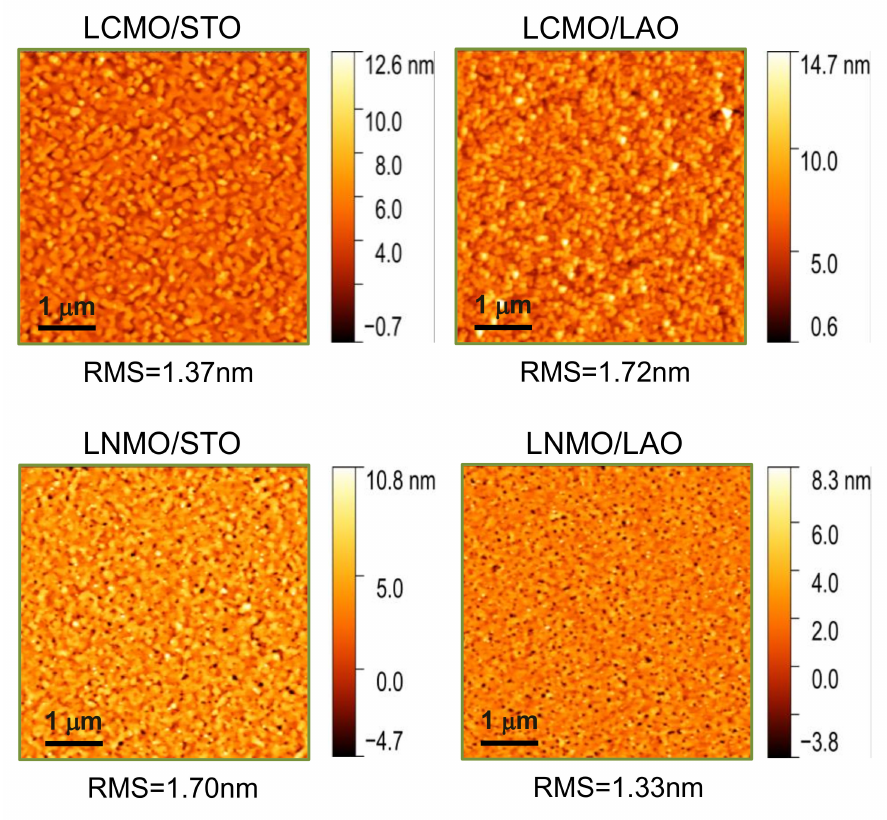
Figure 1. Atomic force microscopy surface topography images (5 × 5 µ m 2 ) of representative La 2 CoMnO 6 and La 2 NiMnO 6 thin films, with thickness values of about 20 nm, on top of SrTiO 3 (STO) and LaAlO 3 (LAO) substrates. Films thermally treated in rapid thermal annealing (RTA) conditions, 20 ◦ C / s heating ramp, dwell time 20 min at 900 ◦ C in static oxygen. In all cases, root mean square (RMS) roughness values are below 2